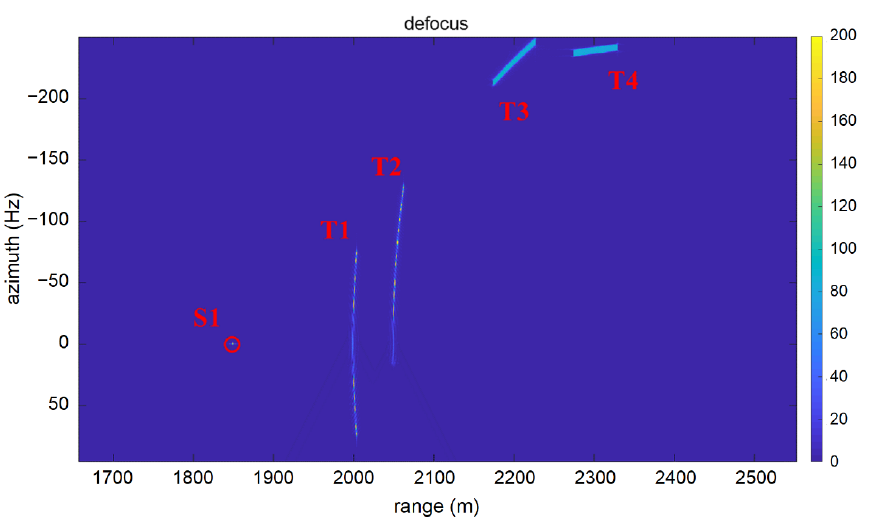
Figure 6. The defocused image without refocus processing. Case 1: target position y = 0 at t azi = 0 When